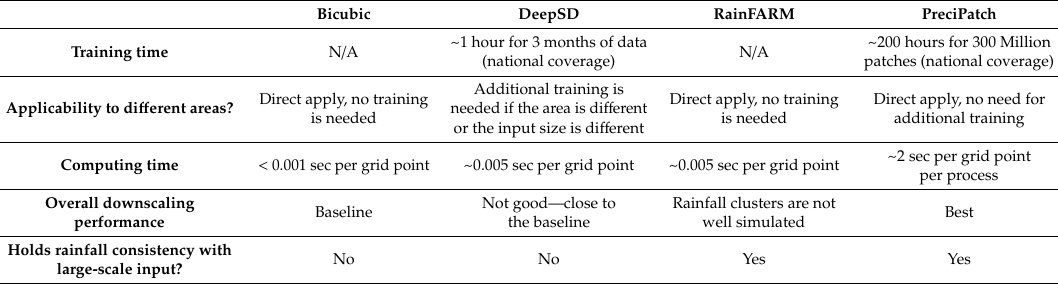
Table 10. Comparison of tested downscaling